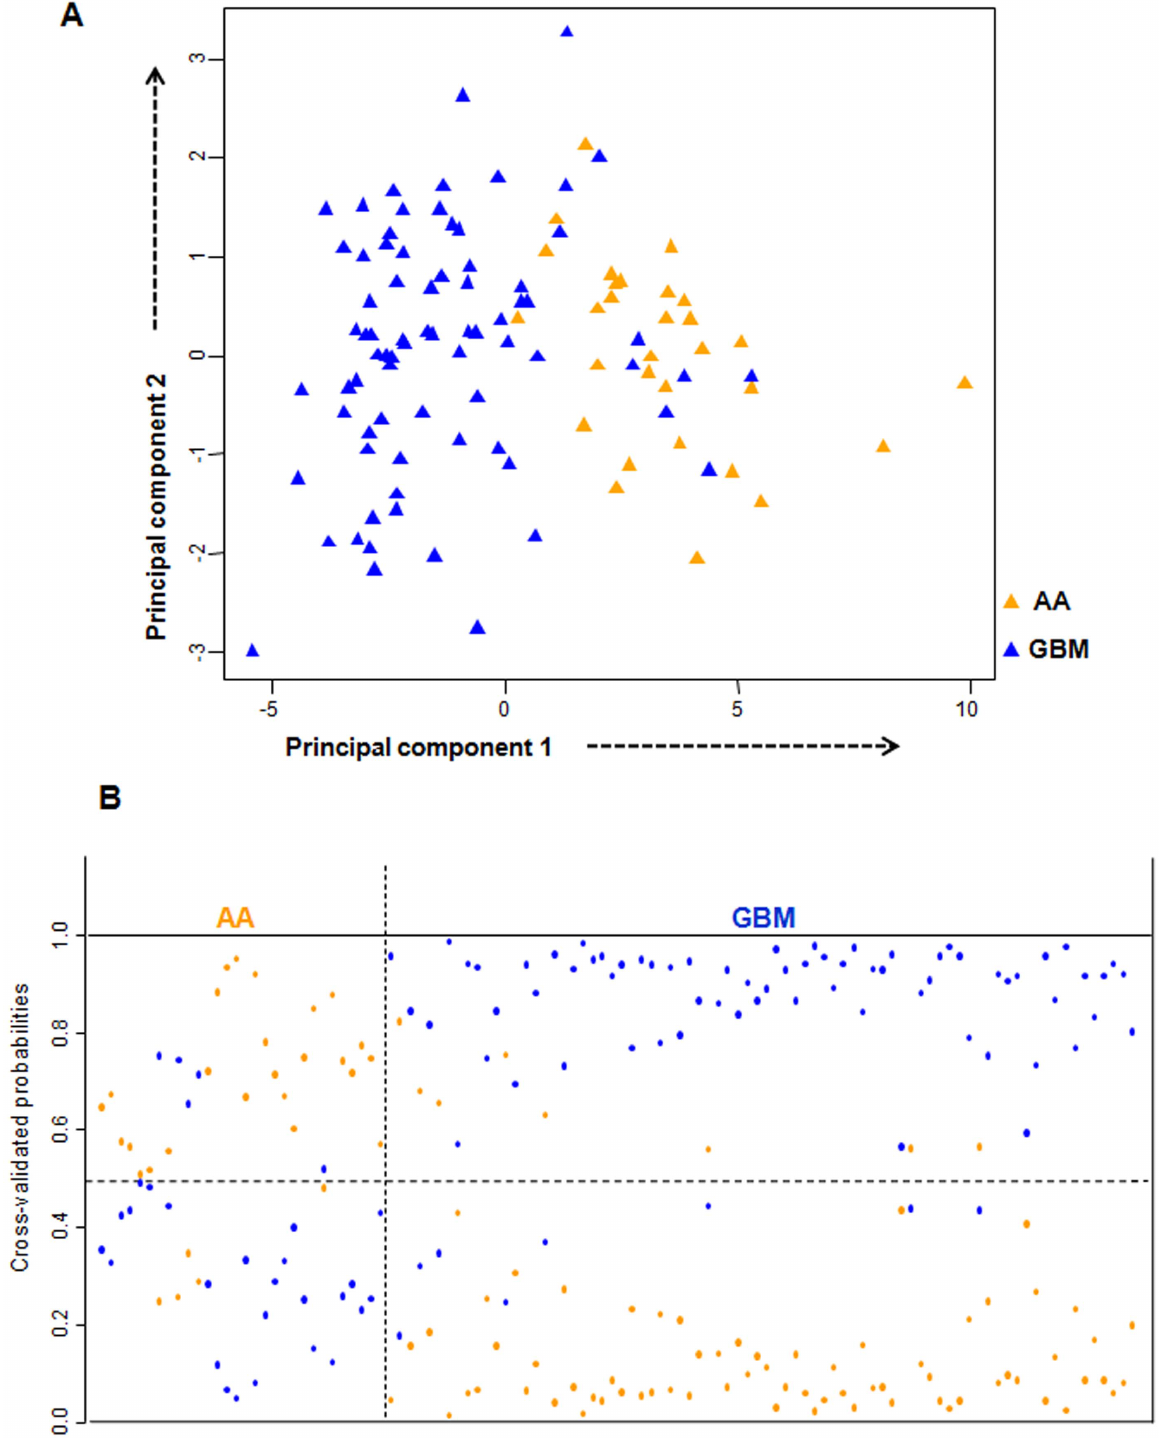
Figure 3. PCA and cross validated probabilities of AA and GBM samples of training set. A. PCA was performed using expression values of 16- PAM identified genes between AA (n=30) and GBM (n=78) samples in training set. A scatter plot is generated using the first two principal components for each sample. The color code of the samples is as indicated. B. The detailed probabilities of 10-fold cross-validation for the samples of training set based on the expression values of 16 genes are shown. For each sample, its probability as AA (orange color) and GBM (blue color) are shown and it was predicted by the PAM program as either AA or GBM based on which grade’s probability is higher. The original histological grade of the samples is shown on the top.